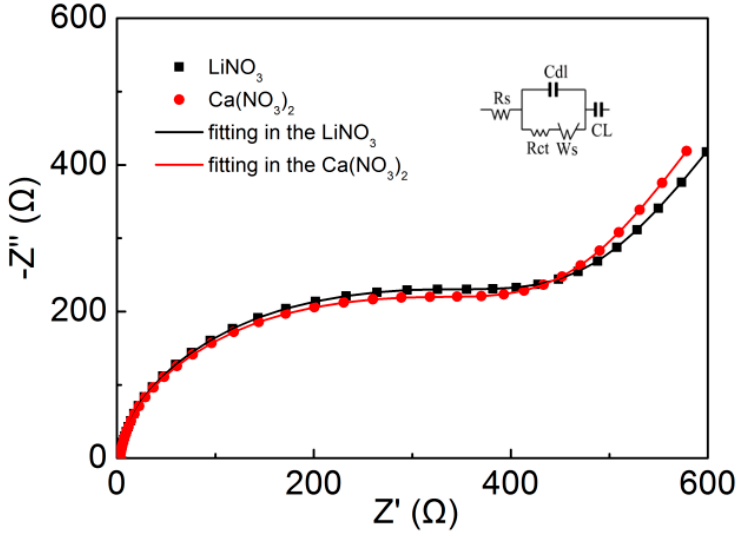
Figure 5. Nyquist plots of the Fe 2 O 3 @CC electrode in aqueous LiNO 3 and Ca(NO 3 ) 2 electrolytes. The circuit for fitting is inserted in the figure.